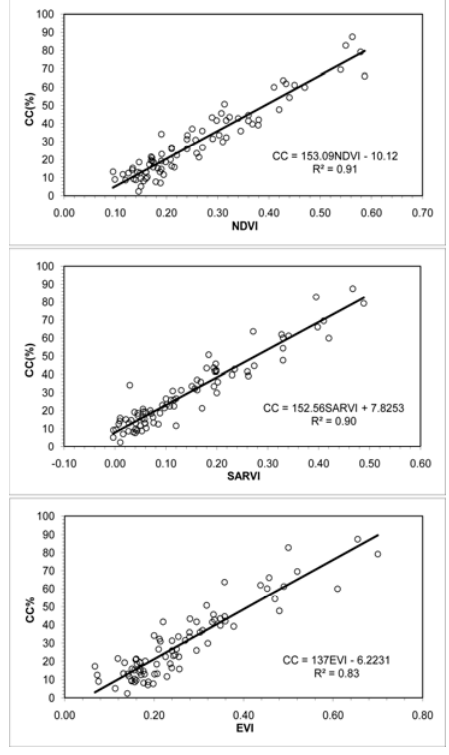
Figure 3. The relationship between the measured canopy cover (CC%) and vegetation indices (VIs) The 8-days interval MODIS09Q1 reflectance data of which bands 1 (Red) and 2 (NIR) have a spatial resolution of 250m of the periods Jul 01 to Sep 30 (12 acquisitions) and Nov 01 to Dec 03 (5 acquisitions) of 2007 (Table 1) were converted into